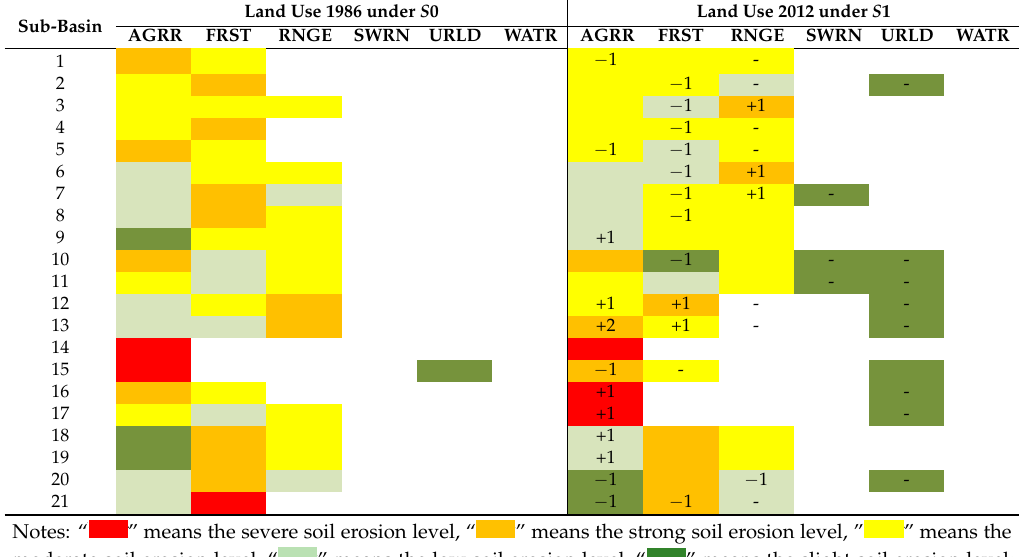
” means the low soil erosion level, “ ” means the slight